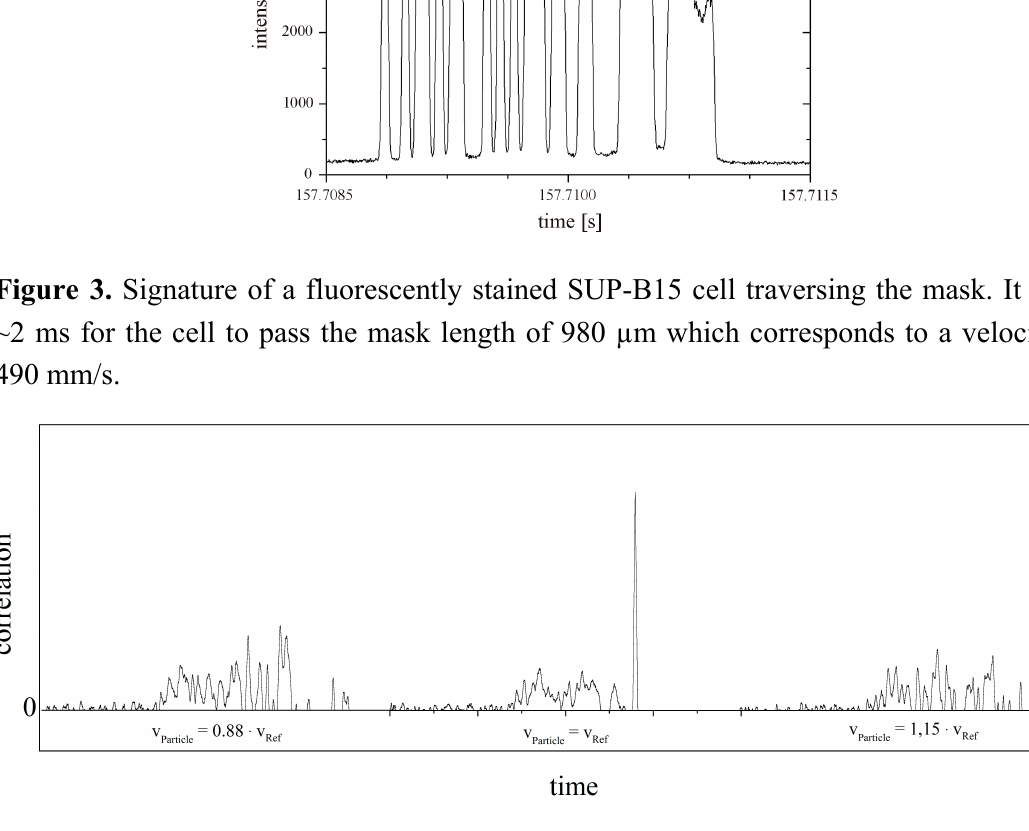
Figure 4. A sequence of three simulated particles with different velocities when analyzed in a single velocity channel at V Ref . The correlation in the center is in resonance ( V Particle = V Ref ) and thus yields the largest main peak amplitude with side lobes located near the main peak. The correlations at the far left ( V Particle = 0.88 × V Ref ) and at the far right ( V Particle = 1.15 × V Ref ) are off-resonance and result in a non-existing main peak and only side